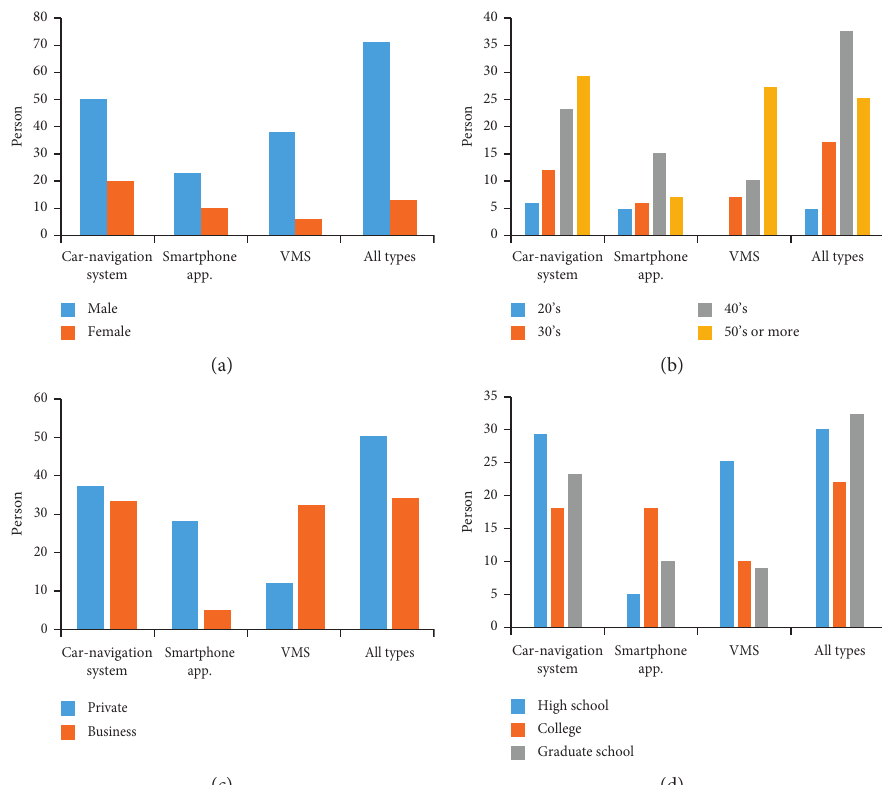
Figure 1: Preference for receiving road freezing risk information by (a) gender, (b) age, (c) type of vehicle, and (d) level of education.